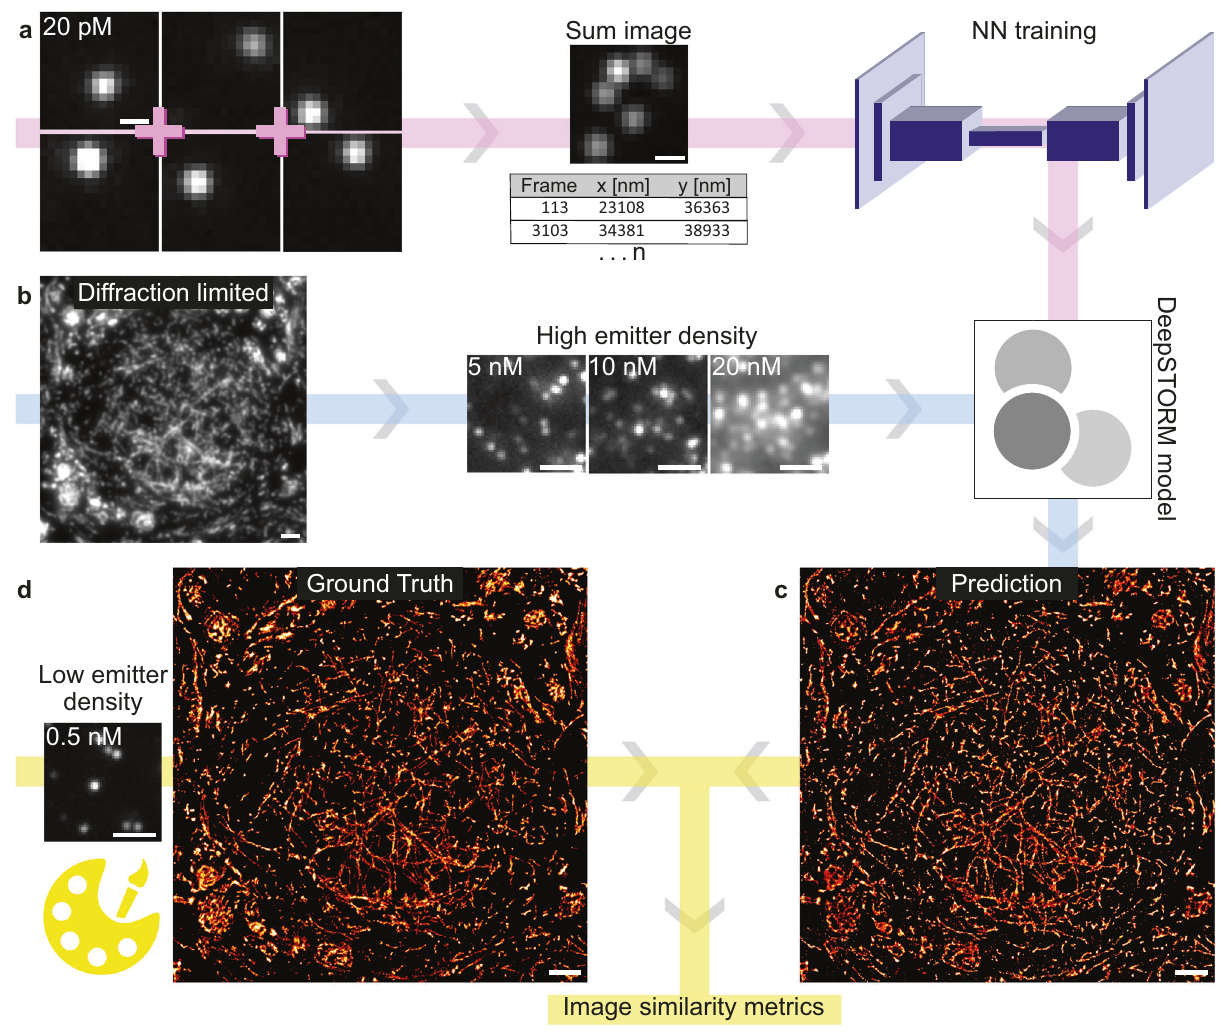
Fig. 1 | Neural network (NN)-assisted DNA-PAINT imaging. a Sparse emitter densityDNA-PAINTimages(20pMimagerstrands)weresummedintohighemitter densitypatches,andtogetherwiththesingle-moleculecoordinatesservedasinput for the DeepSTORM U-Net architecture to train a DeepSTORM model (pink fl ow chart). b DNA-PAINT imaging of tissue samples was performed with different concentrations of fl uorophore-labelled imager strands (5, 10, and 20nM) yielding varying emitter densities. High emitter density DNA-PAINT frames were input into